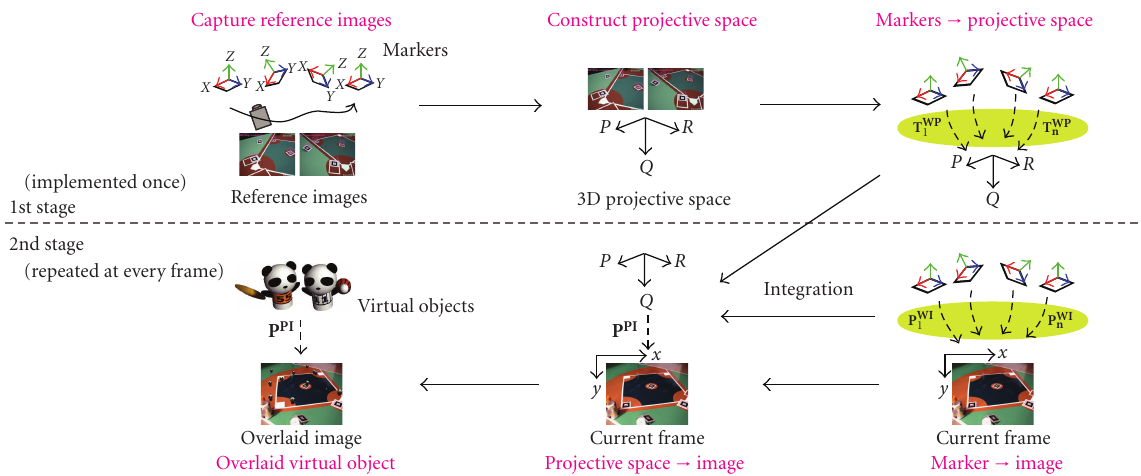
Figure 3: Overview of the registration method with 3D projective space.